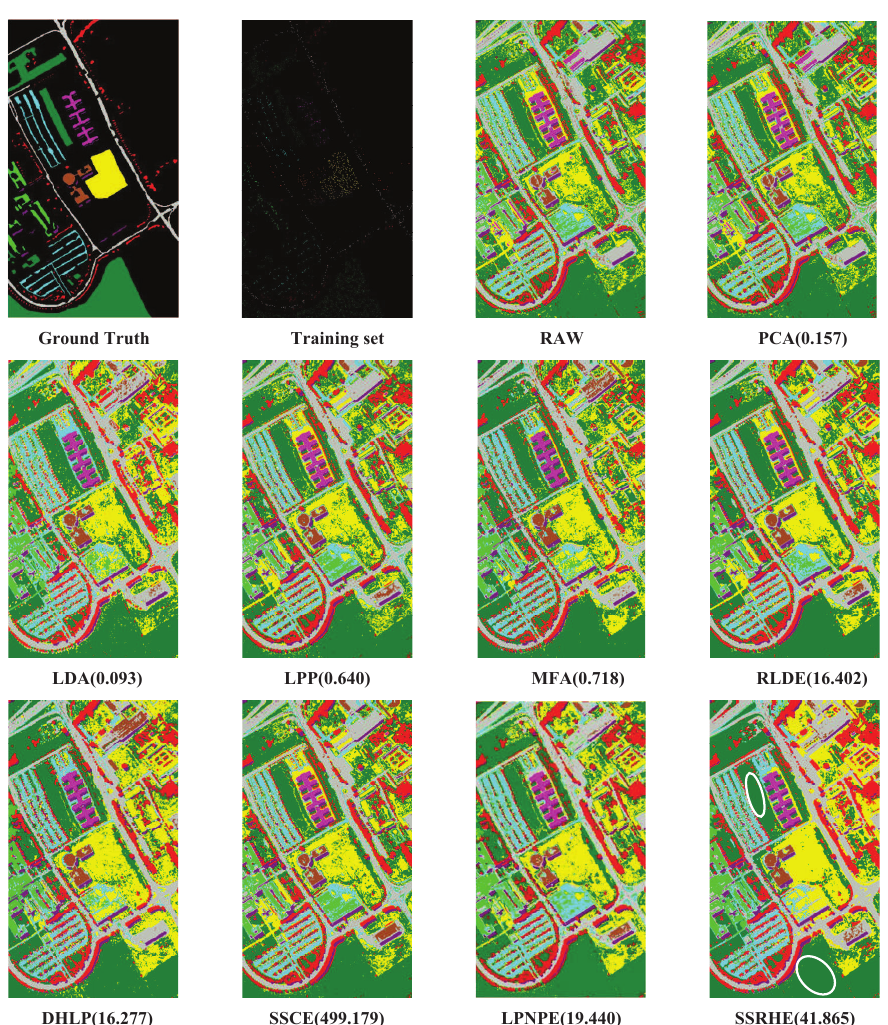
Figure 11. Classification maps of different DR methods with 1-NN on the PaviaU dataset. Note that the time cost of corresponding DR algorithms is marked in